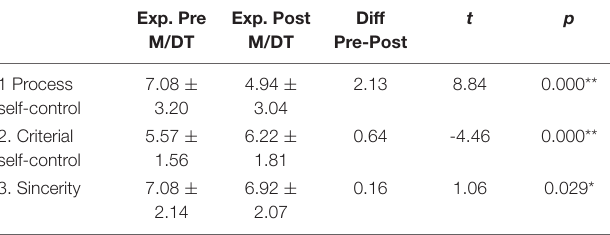
TABLE 3 | CACIA, comparative pretest/post-test.